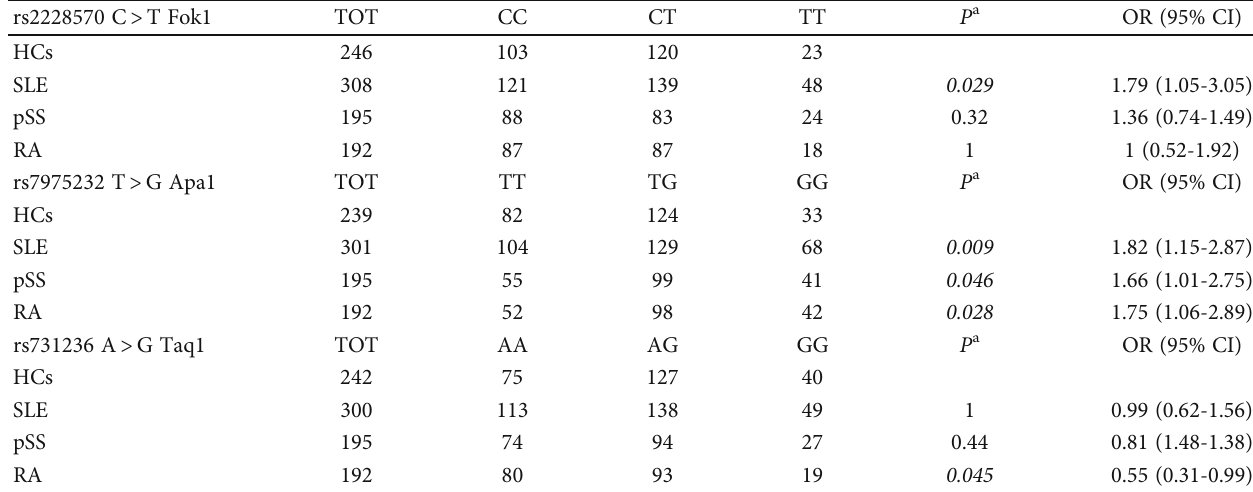
Table 1: Genotype distribution of VDR polymorphisms in SLE, pSS, RA, and